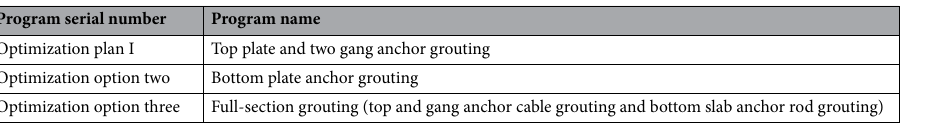
Table 5. Three grouting schemes.